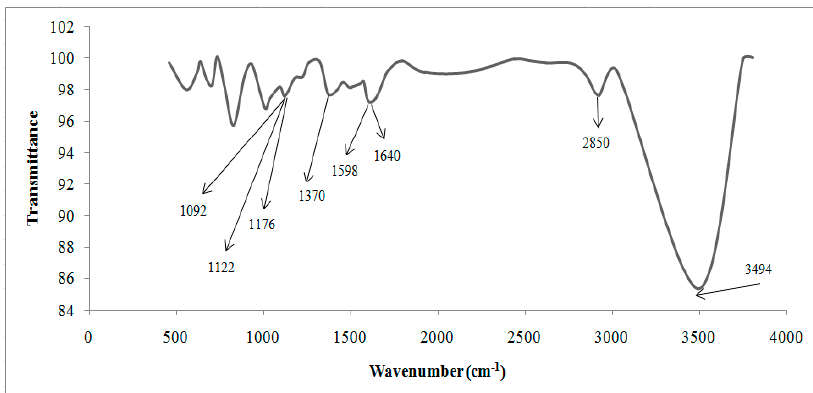
Figure 4. Infrared spectrum from strongly basic resin.